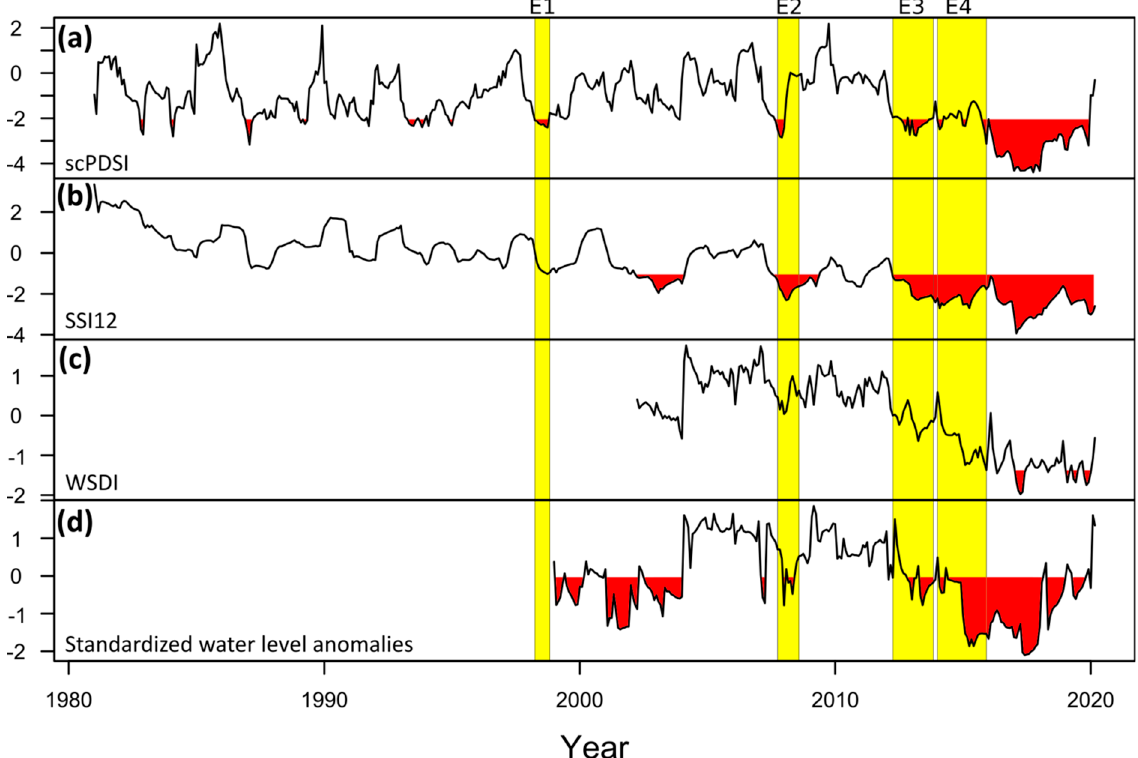
Figure 10. Temporal variation of the area-averaged values over the entire SFRB of the ( a ) scPDSI during 1981–2020 and ( c ) WSDI during 2002–2020. Temporal variation of values of ( b ) SSI12 at the Boqueirão streamflow gauge during 1981–2020 and ( d ) standardized anomalies for the water level at the Sobradinho reservoir during 1999–2020 (reference period: 1999– 2020). The yellow shaded periods on the panels ( a ) to ( d ) indicate the occurrence of the SPEI12-based extreme drought events E1, E2, E3, and E4 shown in Table 3. Red shaded area corresponds to drought conditions for each drought index (see Table 3), while this corresponds to negative anomalies for the water level at the Sobradinho reservoir. The water level at the Sobradinho reservoir provided by the National Electric System Operator (https://bit.ly/3hhz3p3; accessed on 8 May 2021).